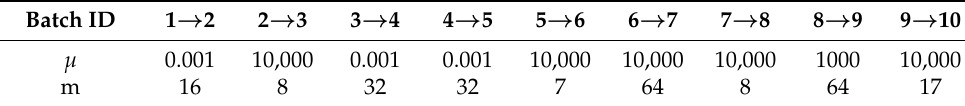
Table 5. Parameter values of the DCKT under Experimental Setting